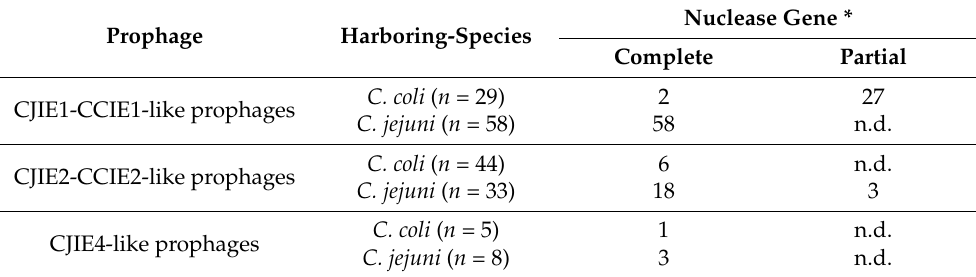
Table 4. Predicted nuclease gene presence among the identified prophages. The